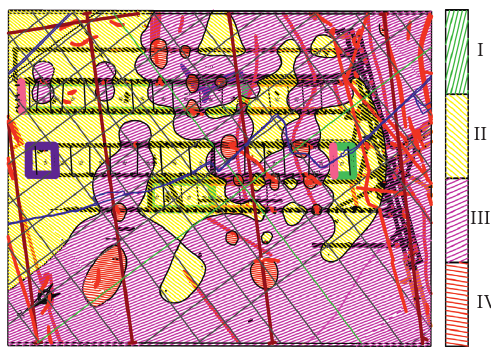
Figure 12: Zoning map of risk grades of roof caving in coal seam No. III.